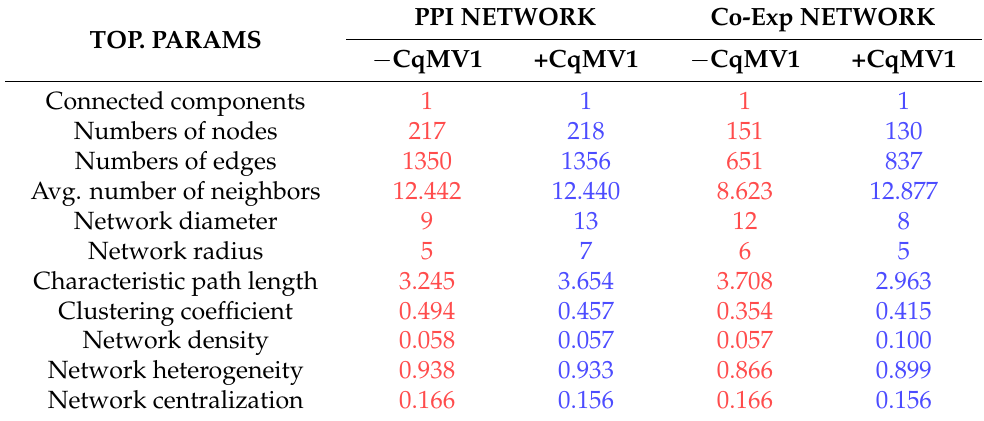
Table 1. Topological analysis of − CqMV1 (in red) and +CqMV1 (in blue) PPI and Co-Exp network models. TOP.